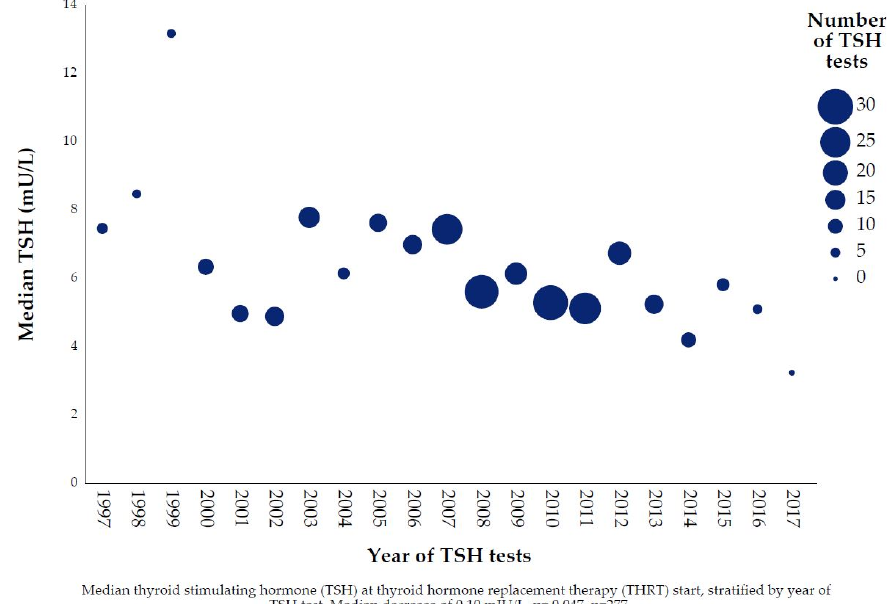
Figure 6. Time trend of median TSH at start of Thyroid Hormone Replacement Therapy.